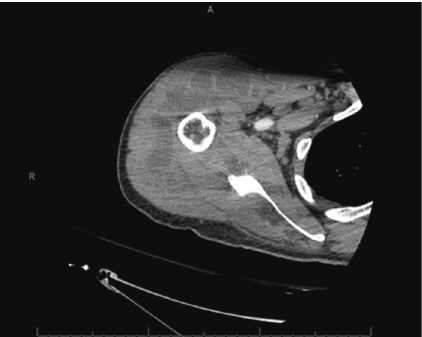
Figure 1: In the right upper extremity, there is a full thickness rota- tor cu ff tear with a glenohumeral joint e ff usion and subacromial subdeltoid bursal fluid. Pockets of gas are noted in the glenohumeral joint e ff usion and the bursal fluid, suggestive of septic joint and septic bursitis with intramuscular